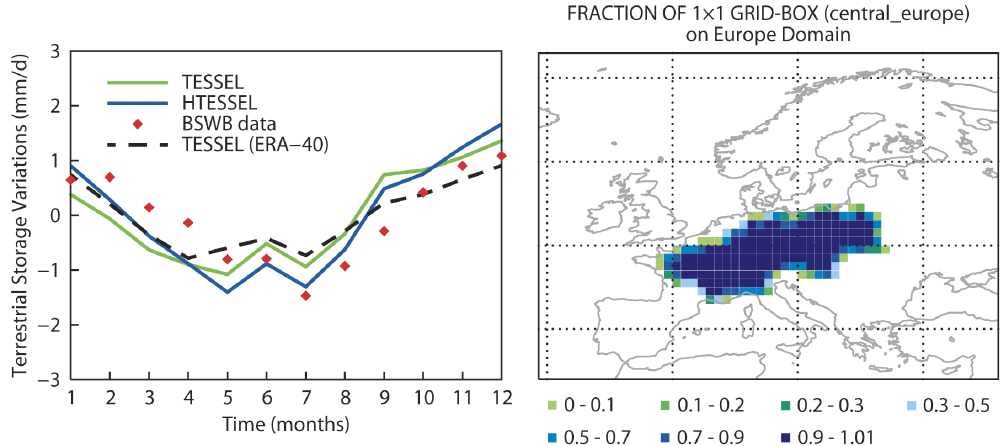
Figure 6. Monthly Terrestrial Water Storage (TWS) changes (left panel) for the Central European catchments Wisla, Oder, Elbe, Weser, Rhine, Seine, Rhone, Po, North-Danube (the coverage is shown in the right panel). The curves are for TESSEL (GSWP-2-driven, green line), H-TESSEL (GSWP-2-driven, blue line), TESSEL in ERA-40 (black dashed line). The red diamonds are the monthly values derived from atmospheric moisture convergence and runoff for the years 1986–1995 in the BSWB dataset [90]. Bare ground evaporation was improved by adopting a lower soil water content threshold for evaporation than the one used for vegetation. The most right panel of Figure 7 shows the difference in Root Mean Square Error (RMSE) of soil moisture between the revised model and the old model. RMSE is computed with respect to in situ measurements of soil moisture over the United States of America [54].